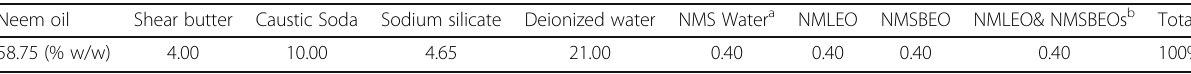
Table 1 Neem soap recipe Neem oil